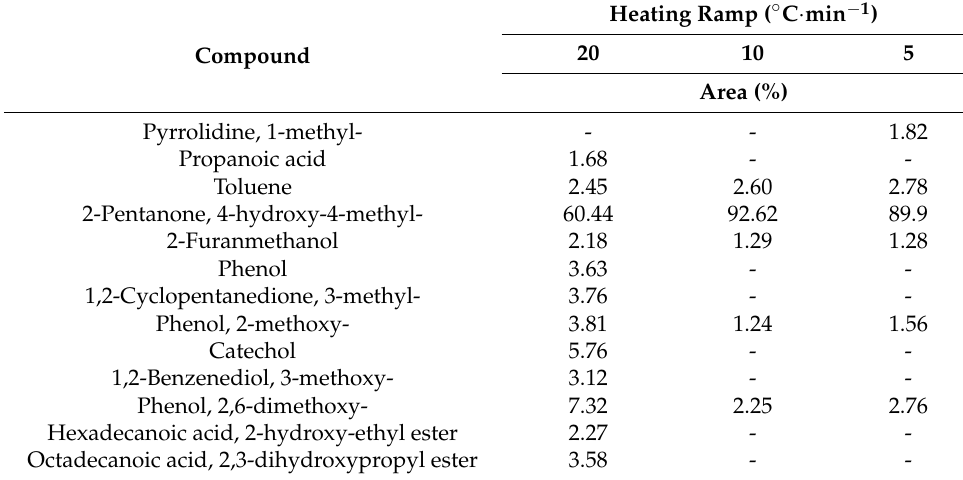
Table 9. Compounds detected in orange pruning bio-oils chromatograms and their relative area percentages using different heating ramps in the